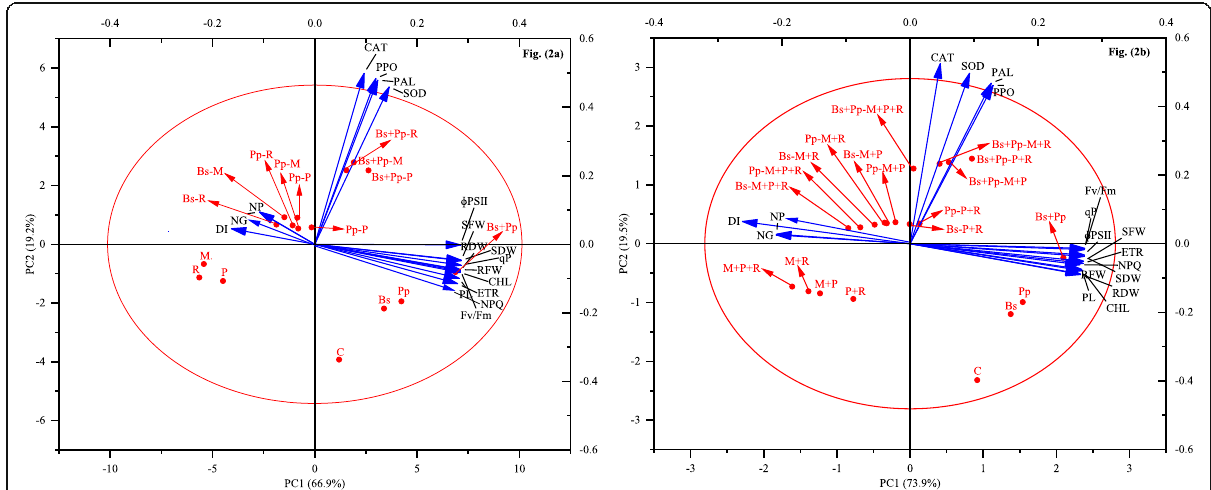
Fig. 2 The biplots of principal component analysis, comparing the effects of B. subtilis , P. putida , and their mixtures on various studied attributes of beetroot infected with a single pathogen ( a ), and two or three pathogens simultaneously ( b ). PL plant length, SFW shoot fresh weight, RFW root fresh weight, SDW shoot dry weight, RDW root dry weight, CHL chlorophyll content, SOD superoxide dismutase, CAT catalase, PPO polyphenol oxidase, PAL phenylalanine ammonia-lyase, Fv/Fm maximal PSII efficiency, ɸ PSII photochemical efficiency of PSII, qP photochemical quenching, NPQ non-photochemical quenching, ETR electron transport rate, C control, M Meloidogyne incognita , P Pectobacterium betavasculorum , R Rhizoctonia solani , Bs Bacillus subtilis , and Pp Pseudomonas